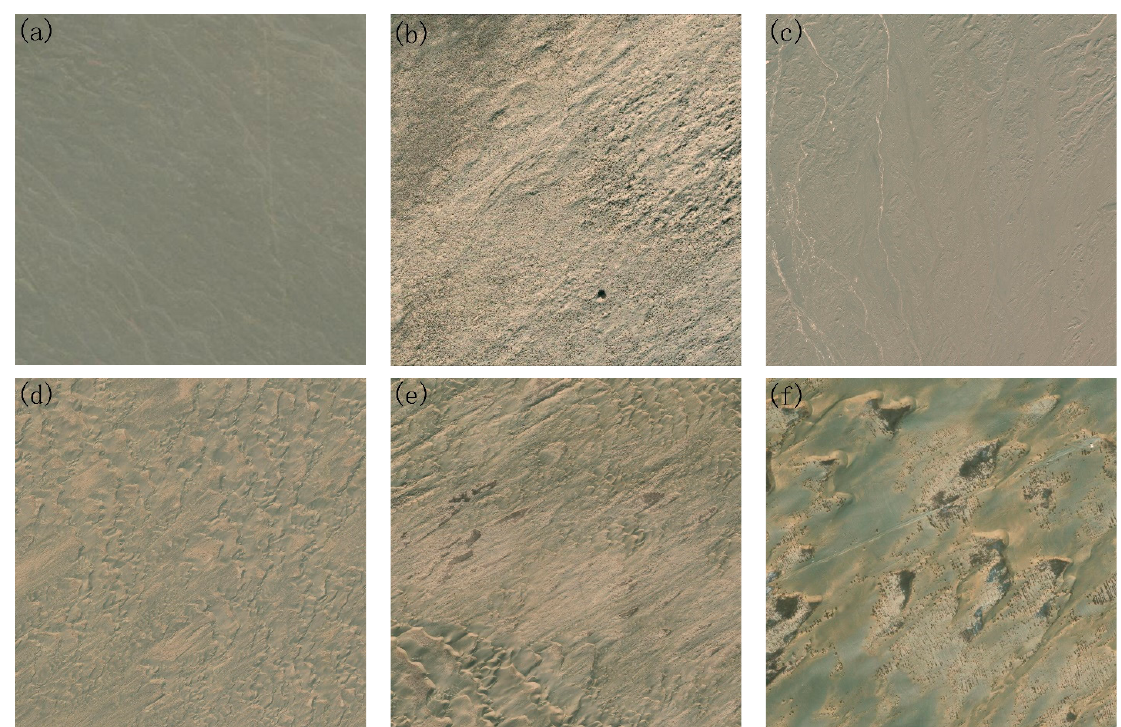
Figure 2. Typical landforms of various sections along the railway: ( a – c ) Gobi; ( d – f ) mobile and semi-mobile dunes. Table 1. Landform types and sand drift rates along the railway.